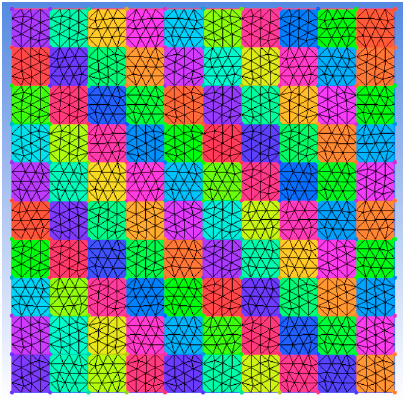
Figure 4. The mesh of benchmark TWIGL.